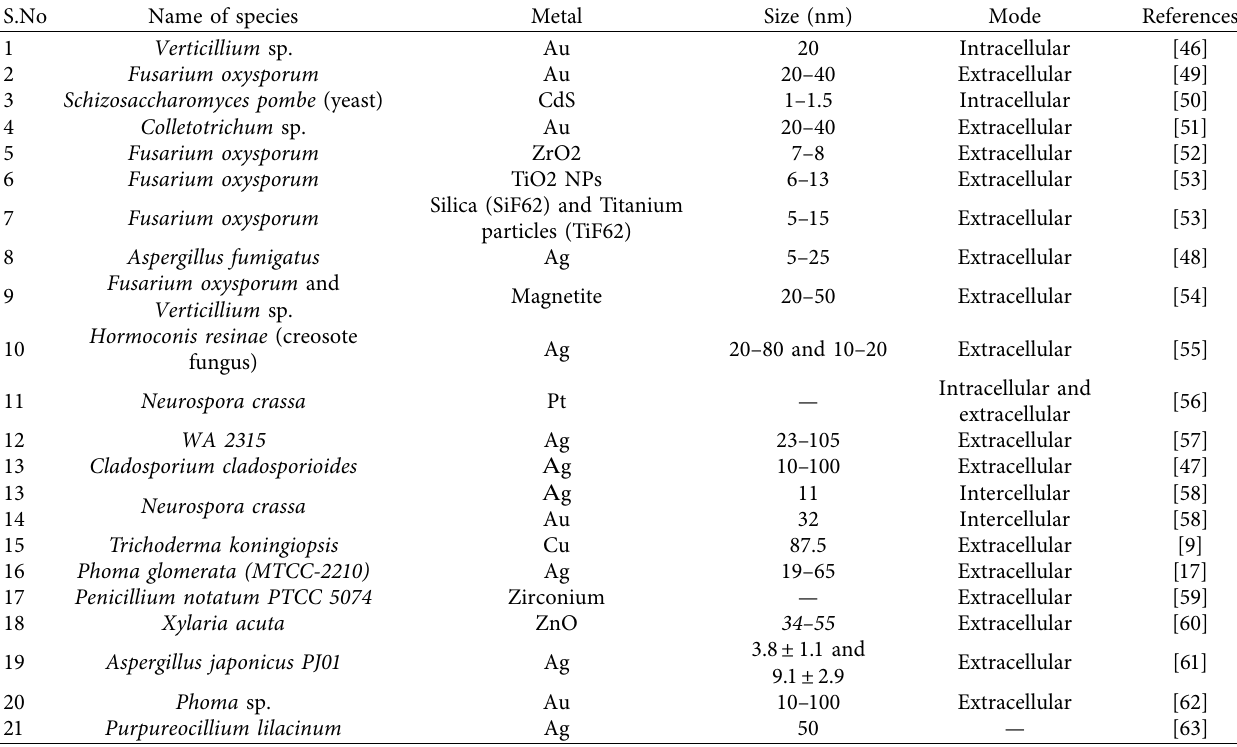
Table 1: Fungi-derived